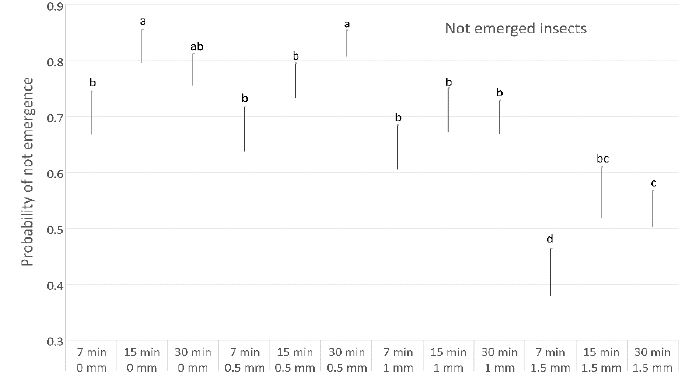
Figure 7. Differences in the probability of not emergence in tests performed with different exposition Figure 7. Di ff erences in the probability of not emergence in tests performed with di ff erent distances and time. Different letters indicate significant differences (Bonferroni multiple comparisons exposition distances and time. Di ff erent letters indicate significant di ff erences (Bonferroni multiple test). comparisons test).